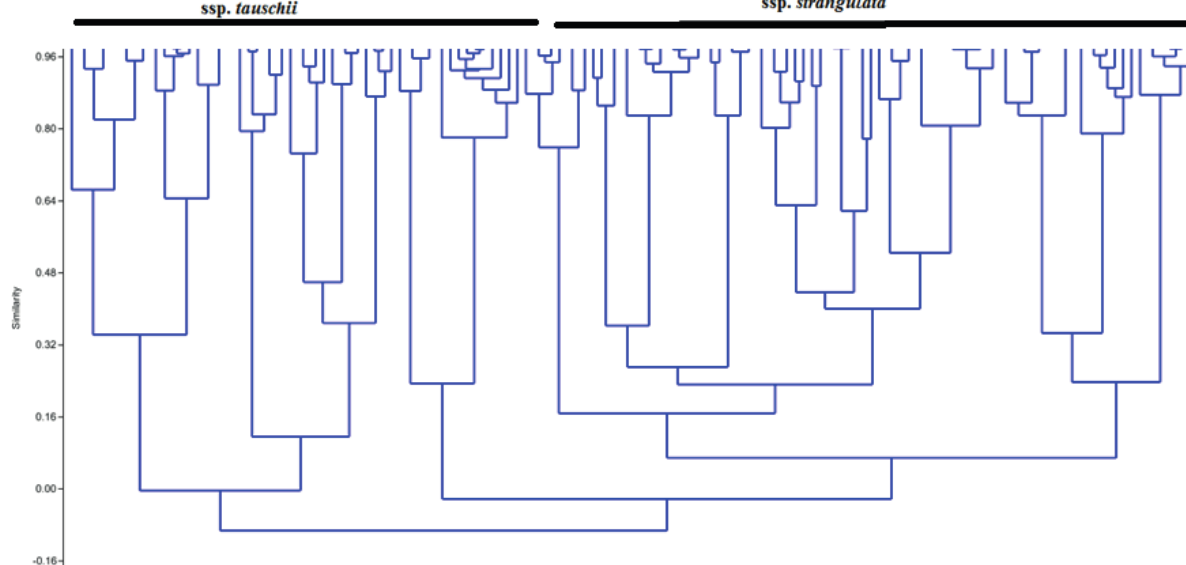
Figure 2. UPGMA tree of populations in Ae. tauschii based on SCoT molecular markers, (Population numbers are according to Table